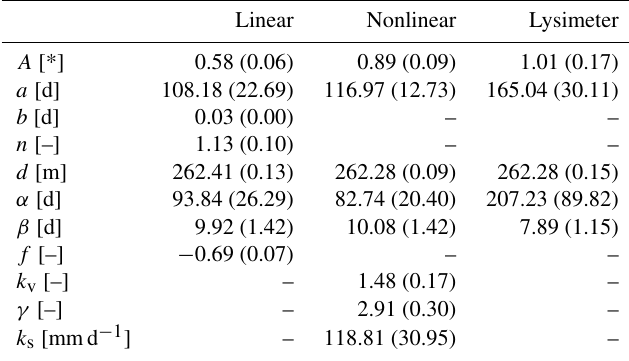
Table A1. Calibrated parameter values for all three model configurations. The estimated standard errors of the parameters are reported between the brackets. The units from parameter A depend on the type of response